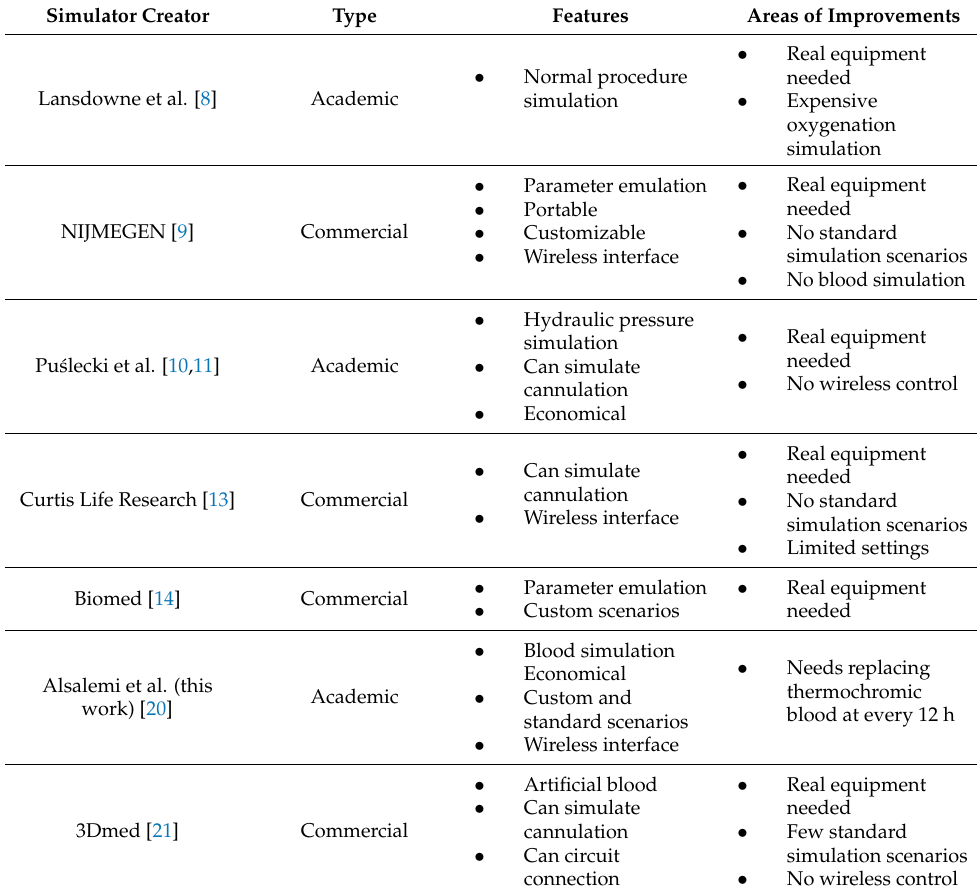
Table 1. Comparison of existing ECMO